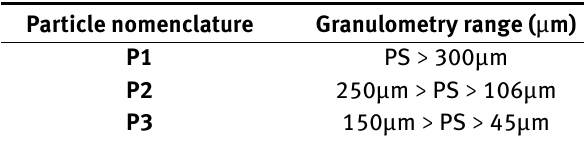
Table 1: Respective classifications for the particle size of NGF. Particle